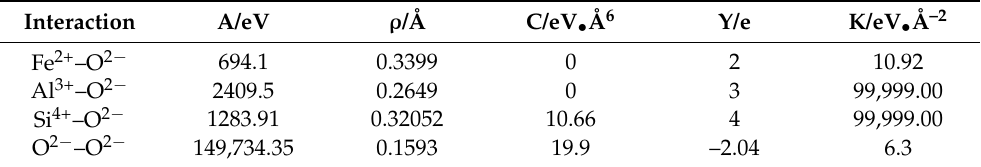
Table 1. Buckingham potential parameters [35,36] were used in the classical simulations